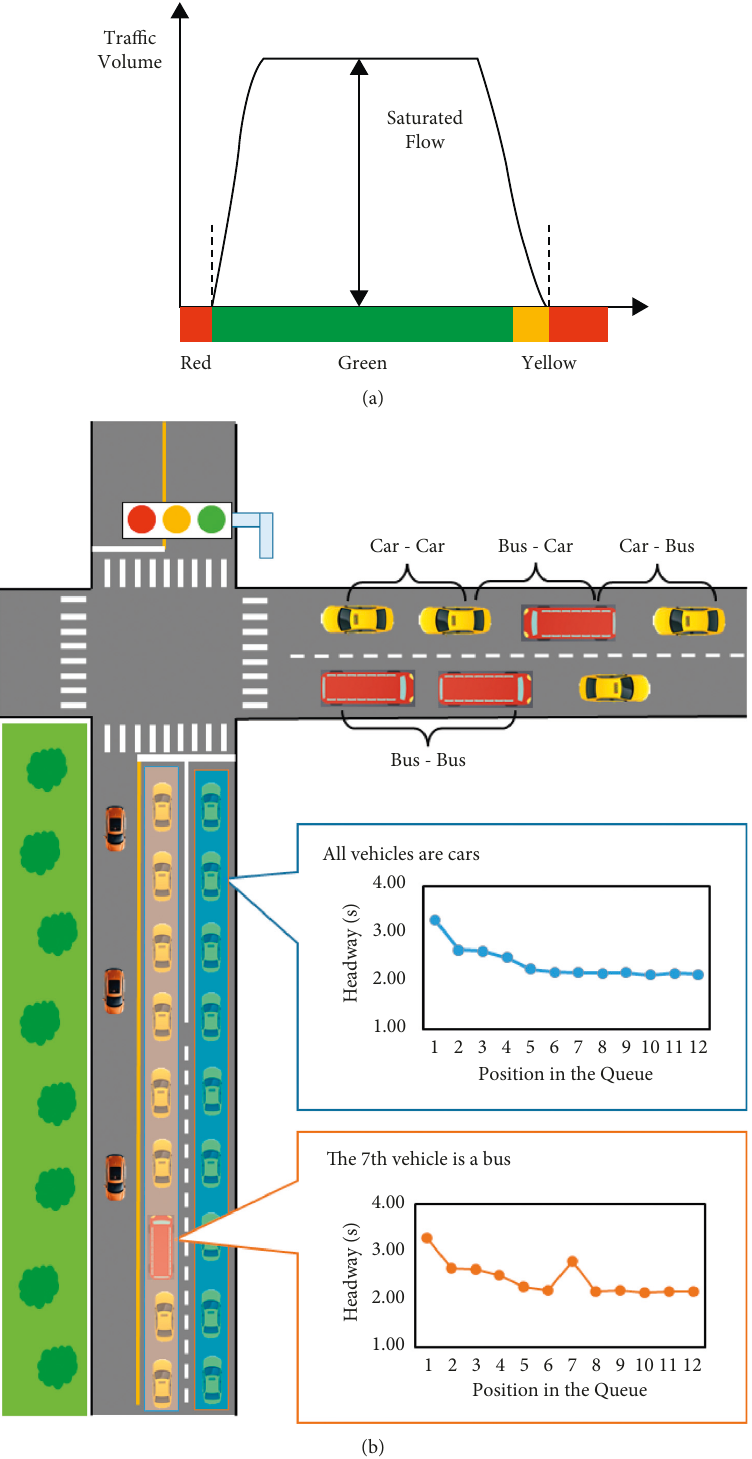
Figure 7: The features of departure vehicles passing the stop line during car-following. (a) Diagram of departure flow at the intersection entrance lane. (b) A common following scenario in mixed